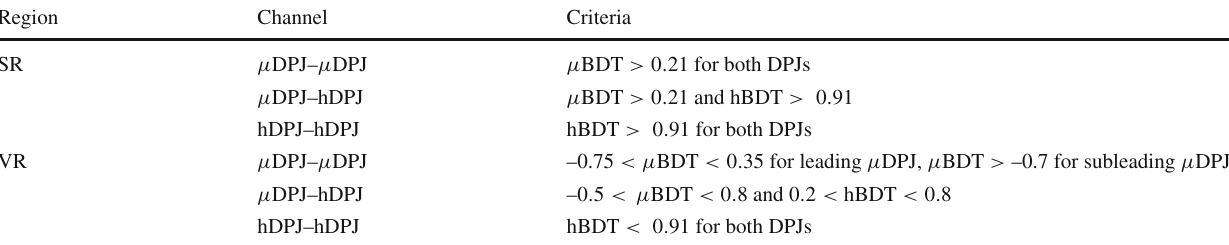
Table 2 Summary of the definitions of the signal regions (SRs) and validation regions (VRs) used in the ABCD method Region Channel